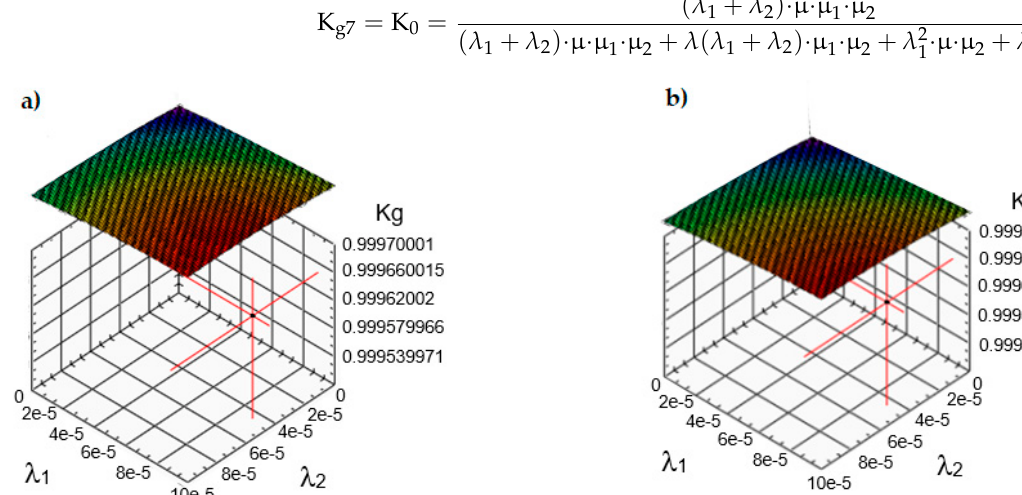
Figure 4. Graphs of the K g availability coefficient in the process of testing the reliability of wind farm devices by changing the value of the average repair time for constant parameters, including: type I mean service time = 0.8 [h]; type II mean operating time = 1.3 [h]; mean time between successive failures = 1200 [h], where: ( a ) mean repair time 0.3 [h]; ( b ) average repair time 0.4 [h].